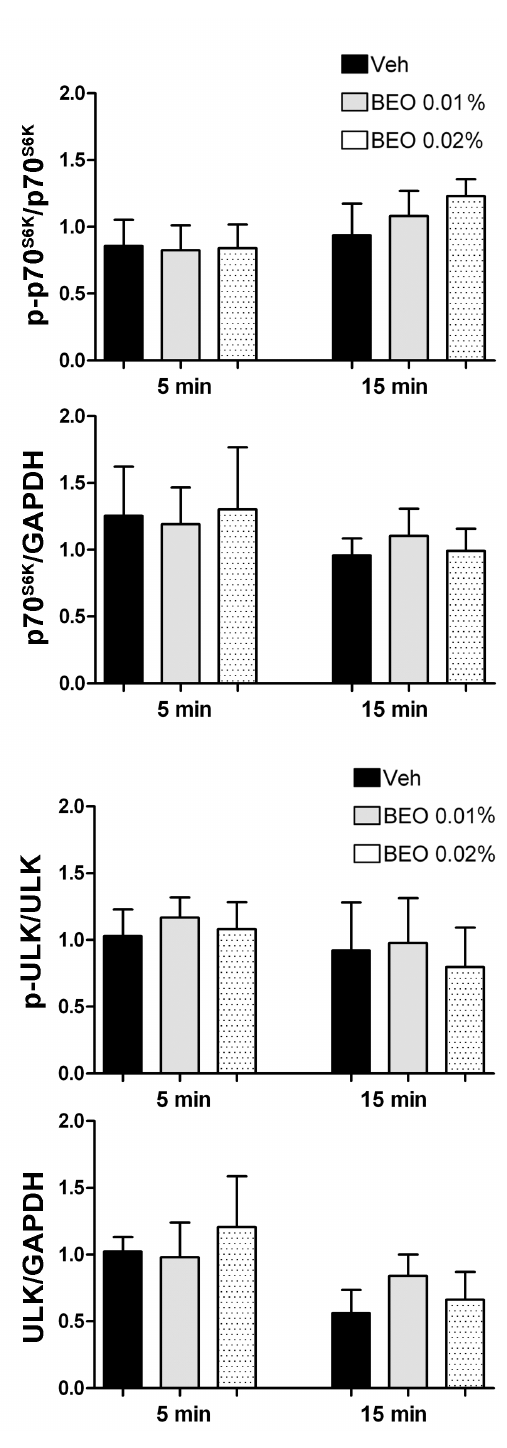
Figure 7. BEO-induced autophagy is mTOR independent. ( A, B ) Treatment with BEO does not affect phosphorylation status of p70 S6K and ULK. ( A ) Representative immunoblots showing the levels of phospho p70 S6K (Thr 389; p-p70 S6K ) and phospho ULK (Ser 757; p-ULK) following treatment with BEO 0.01% and 0.02% for 5 and 15 min. Total protein extracts were analyzed by western blotting for phospho p70 S6K and pULK and subsequently for total p70 S6K and total ULK. GAPDH was used as internal control. ( B ) Histograms show the results of densitometric analysis of autoradiographic bands from three independent experiments (mean ¡ s.e.m.) (V 5 vehicle, 0.0018% ethanol). ( C ) BEO enhances autophagy induced by rapamycin. Neuroblastoma cells